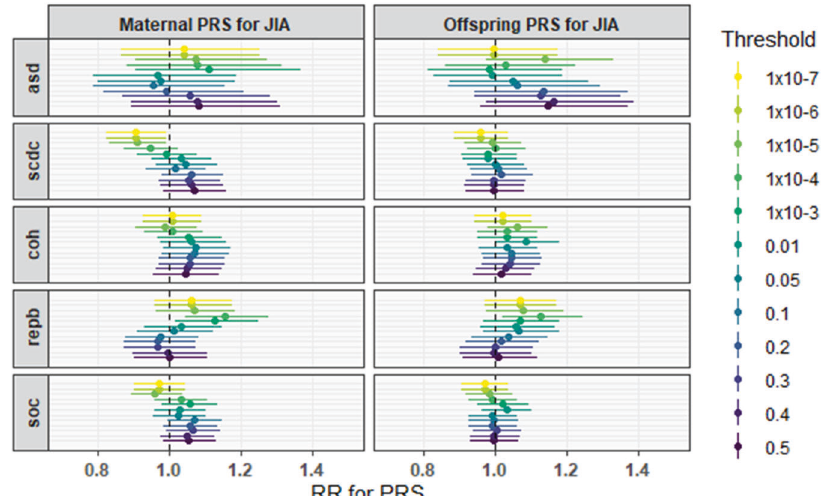
Fig. 1 Associations between PRSs for juvenile idiopathic arthritis and autism-related phenotypes, adjusted for ten genetic principal components, at all SNP p-value thresholds. PRS polygenic risk scores, JIA juvenile idiopathic arthritis, RR relative risk, asd autism cases, SCDC